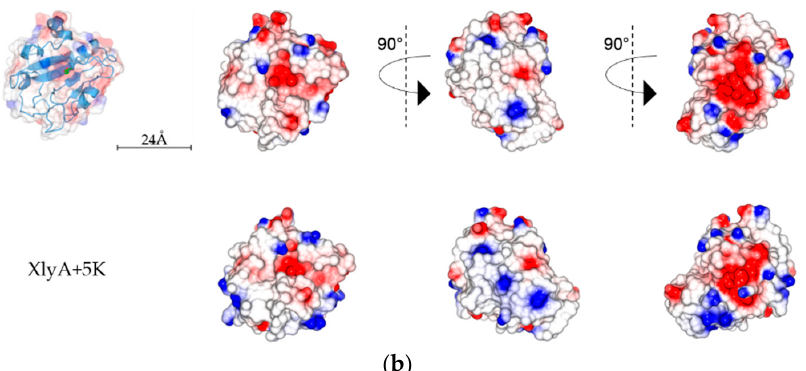
Figure 5. CCP4MG generated electrostatic surface potential maps of PlyC CHAP, XlyA, and their mutants. Surfaces are color-coded according to electrostatic potential (calculated by the Poisson-Boltzmann solver within CCP4MG). The color of the surface represents the electrostatic potential on the protein surface, going from blue (potential of +10kT/e) to red (potential of -10kT/e). ( a ) Electrostatic surface potential of PlyC CHAP WT, CHAP +1, and CHAP +7 in different orientations. The active-site of PlyC CHAP is in a neutral groove observed in the far right column. ( b ) Electrostatic surface potential of XlyA and XlyA+5K in different orientations. The active-site of XlyA is in a negative groove observed in the far right column.